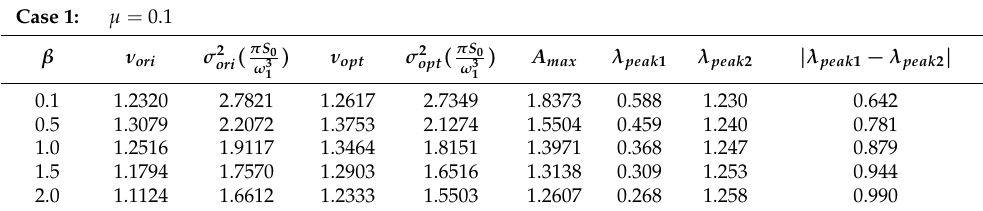
Table A1. The specific parameters of the system in different cases of inerter-to-mass ratio when optimizing the single variable ν ( α 2 opt = α 2 b